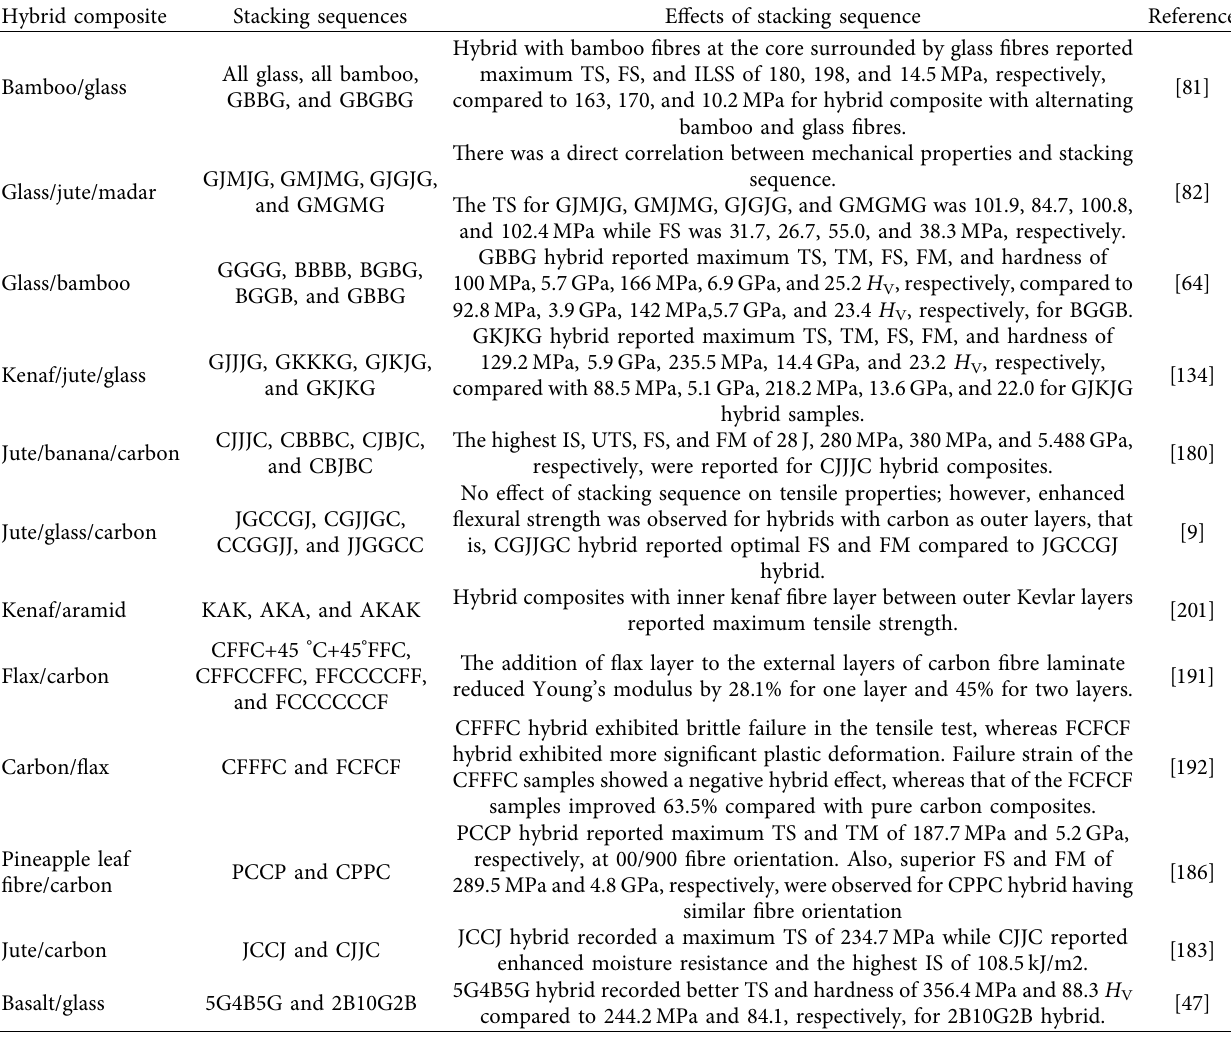
Table 7: Effect of stacking sequence on physical and mechanical properties of resultant hybrid composites. Hybrid composite Stacking